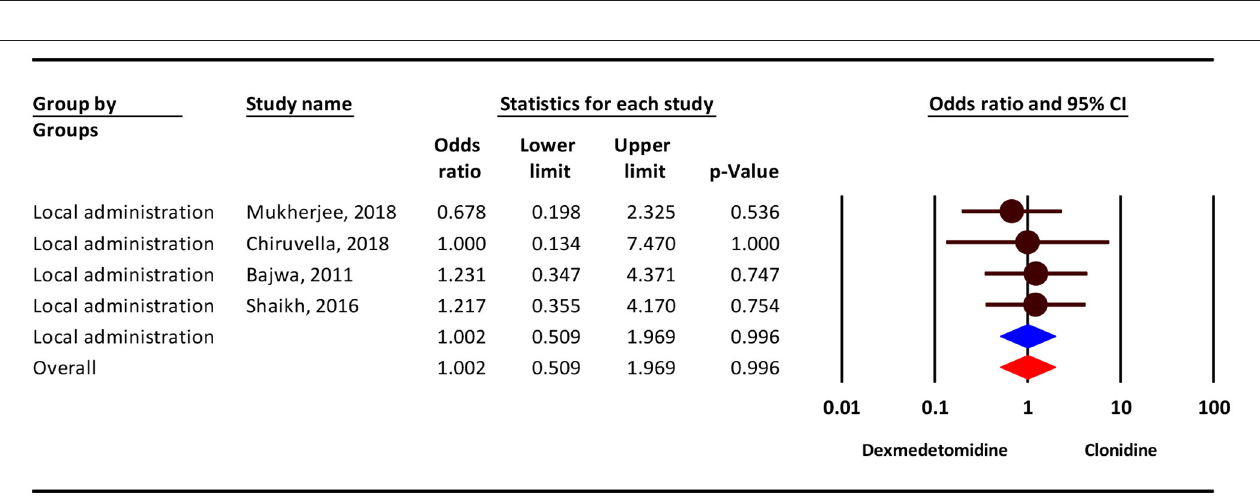
FIGURE 5 | Odds ratio for the risk of shivering as an adverse event associated with the adjuvant use of dexmedetomidine and clonidine in local anesthesia.